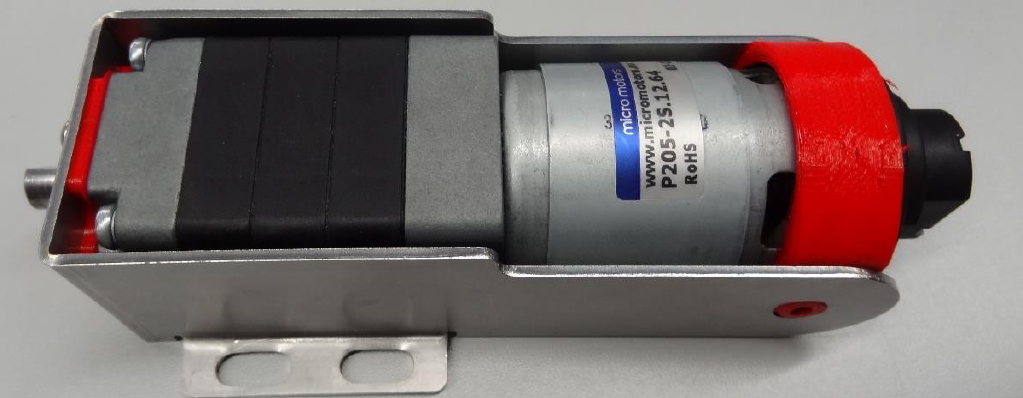
Figure 2. Image of the BDCM used in the APR-02 mobile robot, which includes a 64:1 planetary gearbox and a low-cost magnetic encoder attached to the motor shaft. The motor is supported by an aluminum support structure that has some (red) support elements made of flexible rubber in order to reduce the transmission of vibrations.